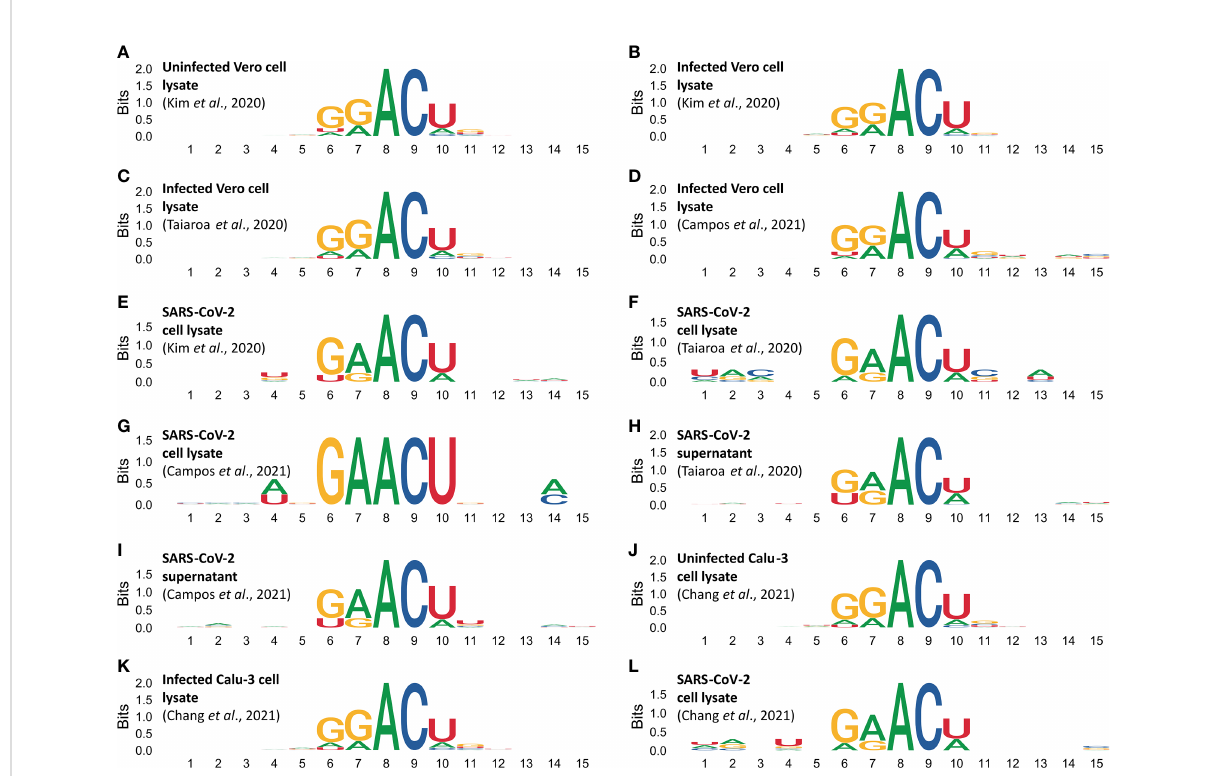
FIGURE 4 Methylated DRACH motifs reveal different sequence pro fi les in the cellular epitranscriptome and the viral epigenome. DRACH sequences containing predicted m6a sites (plus 5 nucleotides for each end) were aligned and stacked together to provide an overview of the informational content of methylated regions. Motif pro fi les in epitranscriptomes were obtained from uninfected Vero cells (A) , and from different samples of infected Vero cells (B – D) . DRACH pro fi les in SARS-CoV-2 epigenomes were obtained from different samples of Vero cell lysates (E – G) , and from different samples of supernatants (H, I) . Motif pro fi les in epitranscriptomes obtained from uninfected Calu-3 cells (J) , infected Calu-3 cells (K) . DRACH pro fi les in SARS-COV-2 epigenome were obtained from infected Calu-3 cells (L) . Direct RNA sequencing data were obtained from Kim et al., 2020 ( in A, B, E) , Taiaroa et al., 2020 (in C, F, H ). Sequencing data obtained by Campos et al., 2021 study are presented in (D, G, I) . Data from Chang et al., 2021 on Calu-3 cells (J – L) . Numbers in the abscissa indicate the DRACH motif positions (from 6 to 10), the fl anking 5 ’ (from 1 to 5) and 3 ’ (from 11 to 15). The ordinates indicate the score in Bits as it deviates from the null hypothesis, in other words the stronger the bias, the higher the score. A and C have 100% frequency in positions 8 and 9 of all DRACH motifs analyzed whereas positions with zero or near zero indicate that the four canonical bases are at equilibrium frequency f (N) = 0.25 in the same sampling